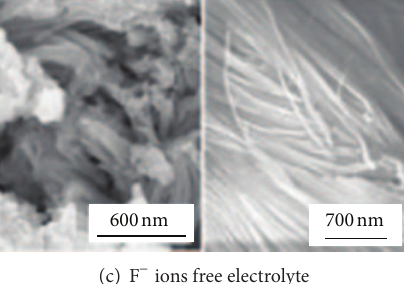
Figure 3: The electrochemical anodization process and typical morphologies: (a) (I) metal electropolishing, (II) formation of compact anodic oxides, (III) self-ordered oxides (nanotubes or nanopores), (IV) ordered nanoporous layers, and (V) rapid (disorganized) oxide nanotube formation. Examples of morphologies of obtained structures: (b) classical ordered TiO 2 nanopores (b1), nanotubes (b2), sponge- like nanoporous structures (b3) anodized in F − ions containing electrolyte, and (c) disordered TiO 2 nanotubes growing in bundles anodized in F − ions free